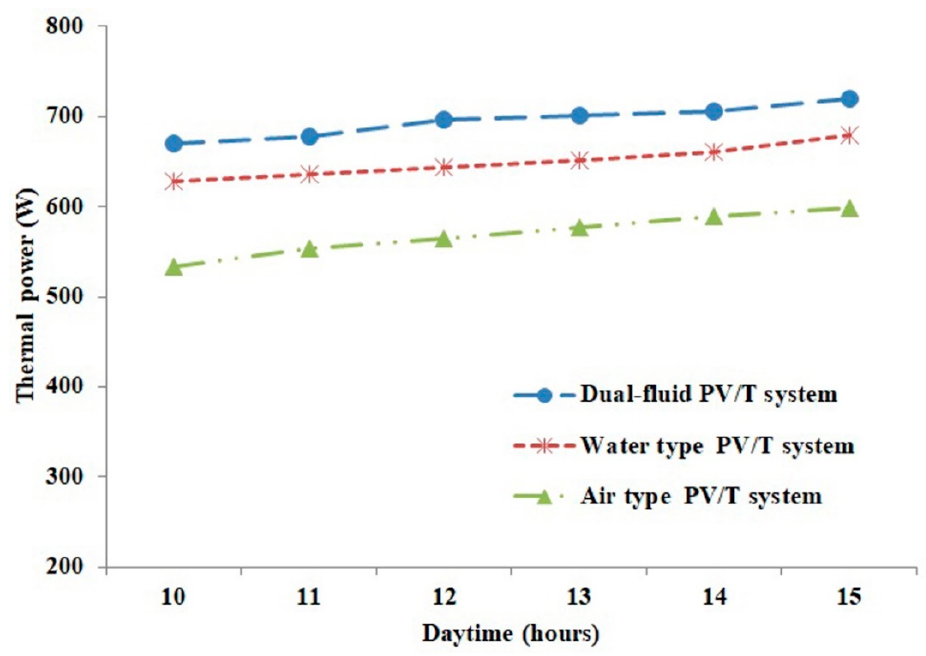
Figure 6. Daily thermal power of PV / T systems plotted against di ff erent fluid operations.